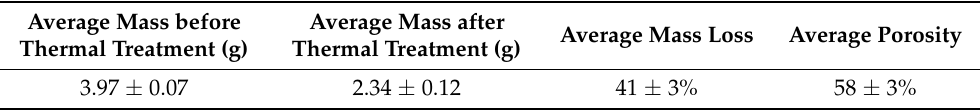
Table 3. The average mass of the produced TiC samples before and after the thermal treatment and the achieved average